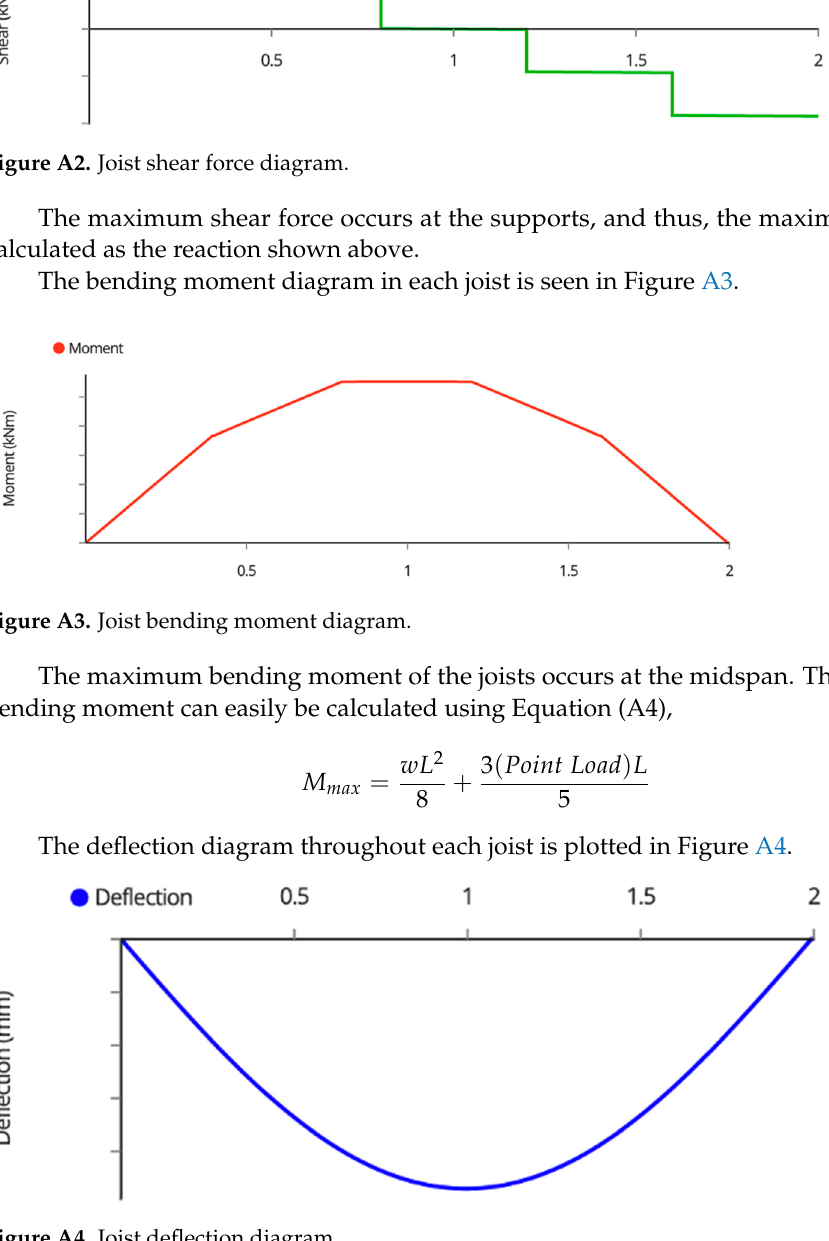
Figure A4. Joist deflection diagram.